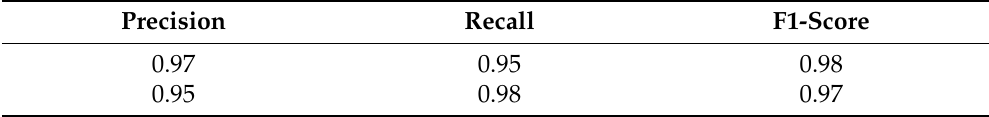
Table 13. Training and test accuracy of